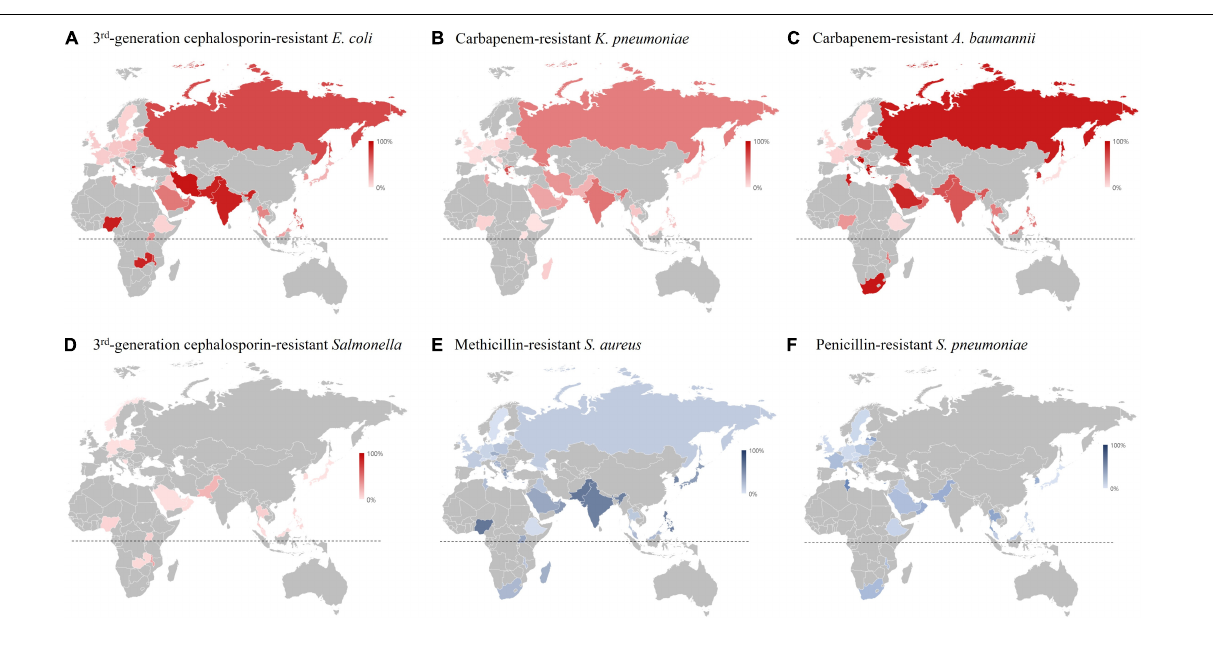
FIGURE 8 | Resistance rate of major multidrug-resistant pathogens in 2017 based on the WHO GLASS report (World Health Organization [WHO], 2019). (A) Resistance rate to third generation cephalosporin of E. coli blood isolates. (B) Resistance rate to carbapenem of K. pneumoniae blood isolates. (C) Resistance rate to carbapenem in A. baumannii blood isolates. (D) Resistance rate to third generation cephalosporin of Salmonella blood isolates. (E) Resistance rate to methicillin in S. aureus blood isolates. (F) Resistance rate to penicillin in S. pneumoniae blood isolates. The dotted lines indicate the equatorial